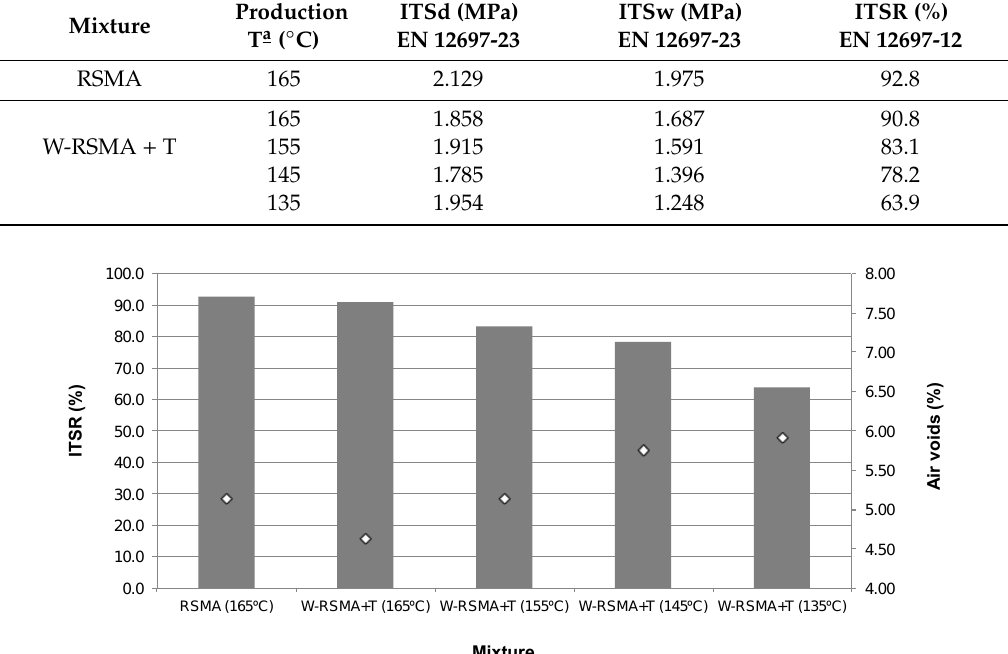
Figure 4. ITSR results for samples prepared with Marshall compactor.